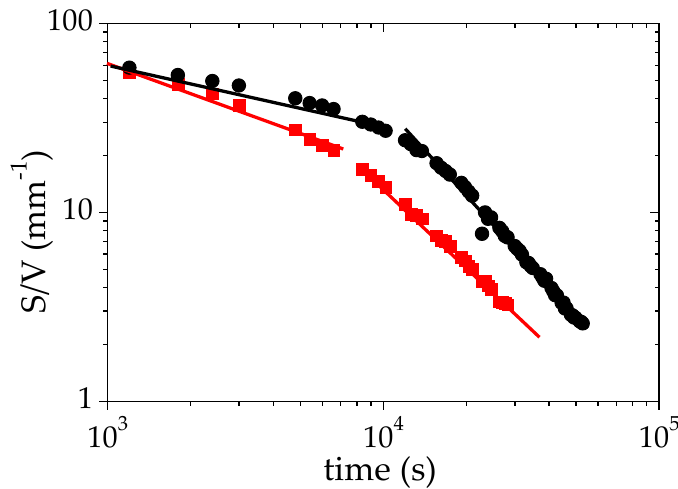
Figure 6. Variation of the specific surface S/V as a function of time during the phase separation of a solution of PMAA in D 2 O ( Φ PMAA,0 = 0.065) under isothermal conditions +1 °C ( ● ) and +10 °C ( ■ ) above the cloud point. The solid lines correspond to the fits to power laws for the two regimes identified on this plot.